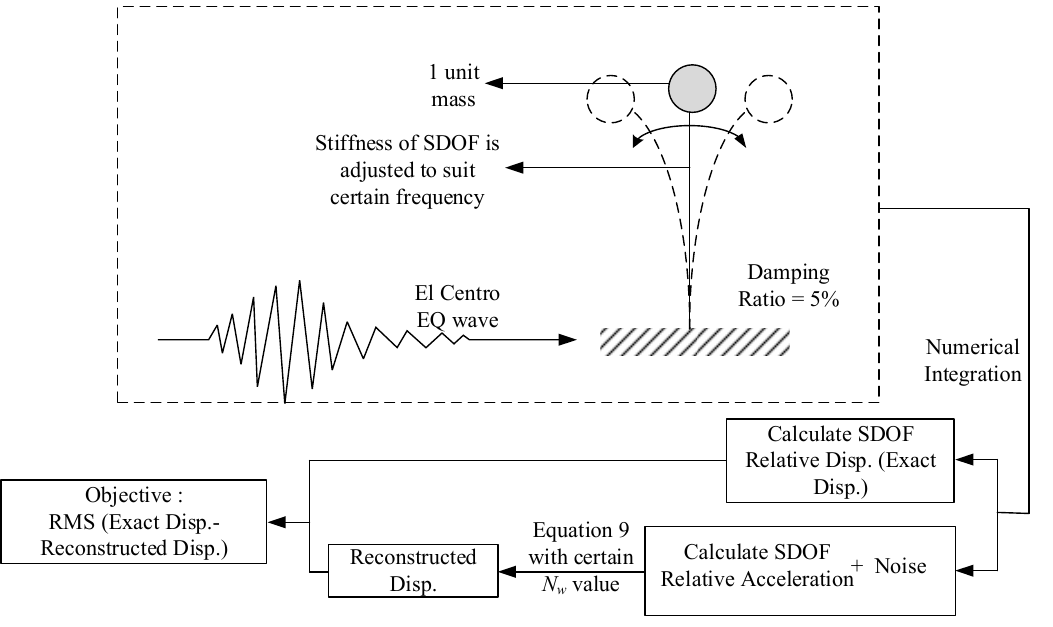
Figure 2. Determination of N w using optimization and single degree of freedom (SDOF).